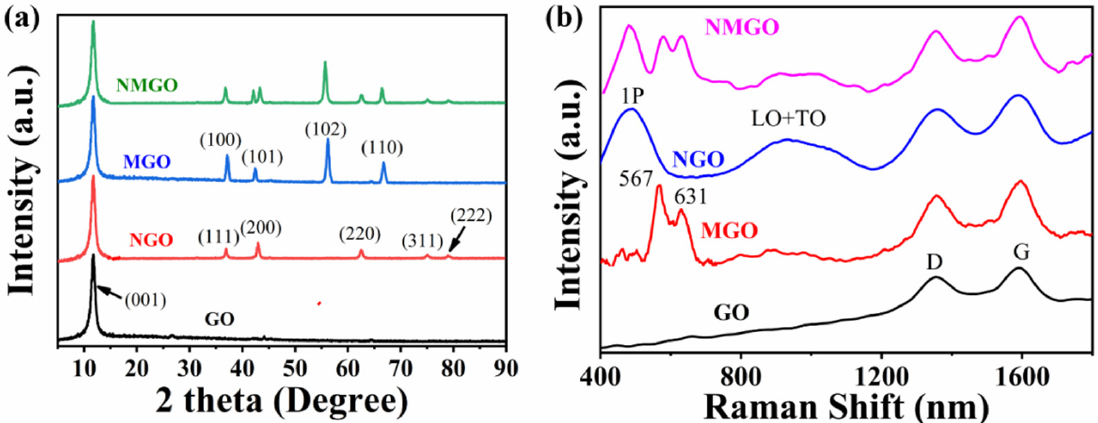
Figure 2. ( a ) XRD plot for GO, NGO, MGO, and NMGO and ( b ) RAMAN spectra for GO, NGO, MGO, and NMGO.